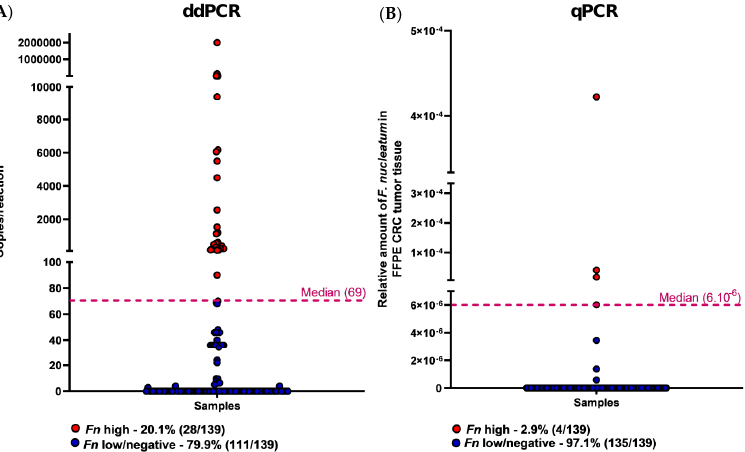
Figure 2. Amount of F. nucleatum in 139 CRC FFPE tumor samples according to each methodology. Dotplots represent samples, and the dotted line represents the median cut-point amount around which samples were classified as having a high (above median) or low/negative (below the median) amount of Fn . ( A ) The distribution of Fn DNA in copies/reaction detected by ddPCR (median = 69 copies/reaction). ( B ) The relative amount distribution of Fn DNA was detected by qPCR (median = 6 × 10 −6 ). Table 2. Clinicopathological and molecular features according to the amount of